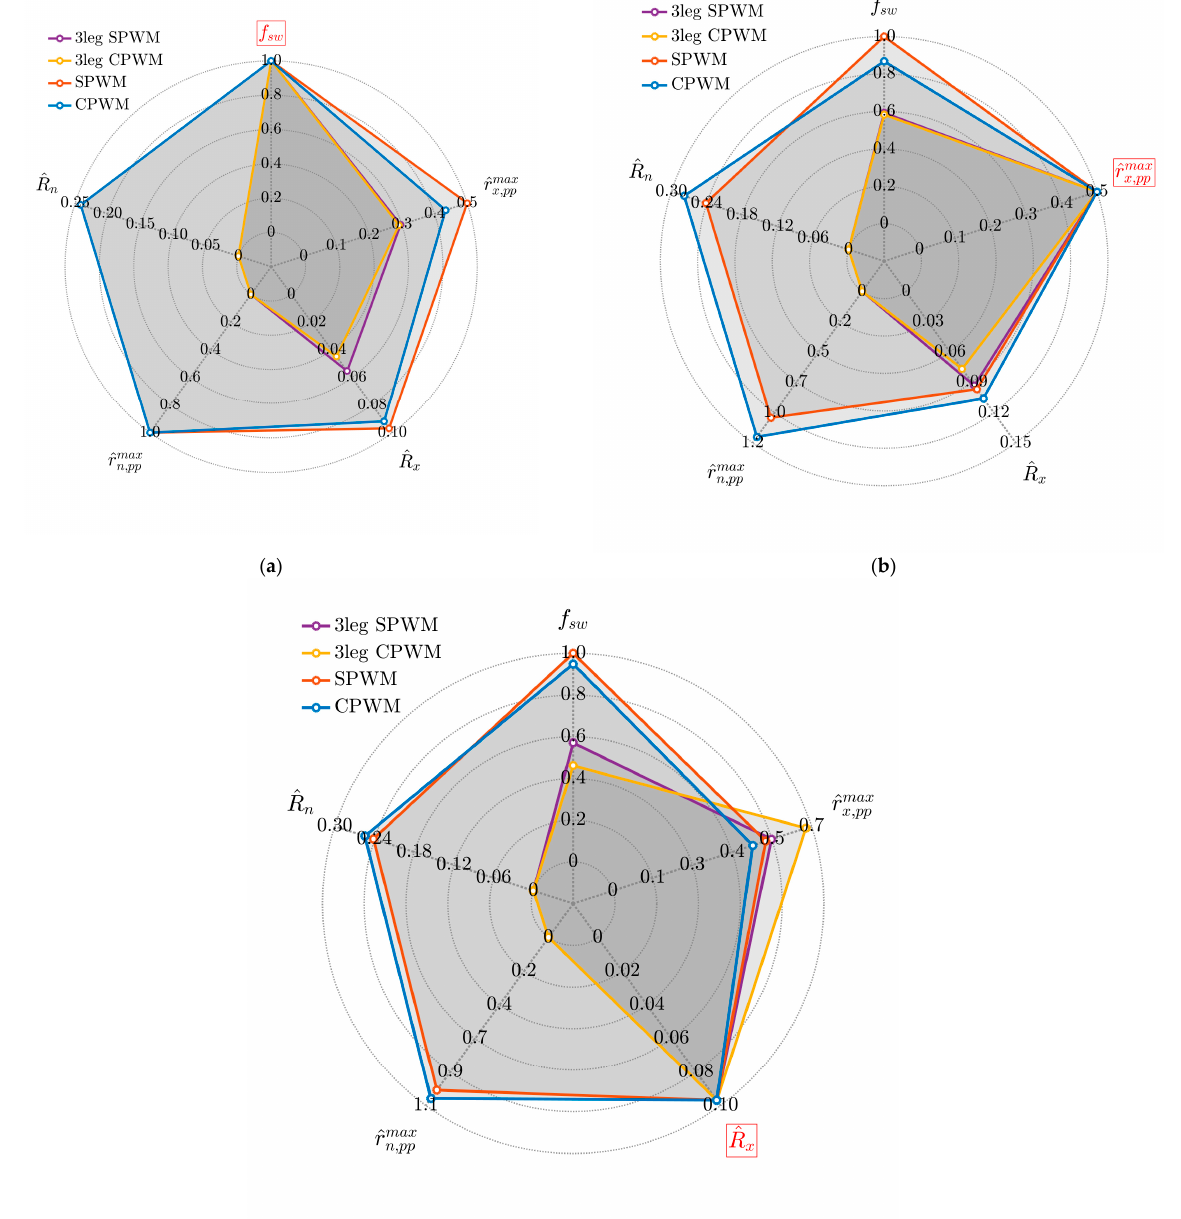
Figure 19. Kiviat (radar) diagrams depicting current-ripple-related performances for compared converter topologies and corresponding modulation techniques @ m = 0.5 and identical fixed metrics: ( a ) switching frequency, ( b ) maximum, normalized, peak-to-peak phase switching current ripple, ( c ) normalized RMS value of phase switching current ripple.